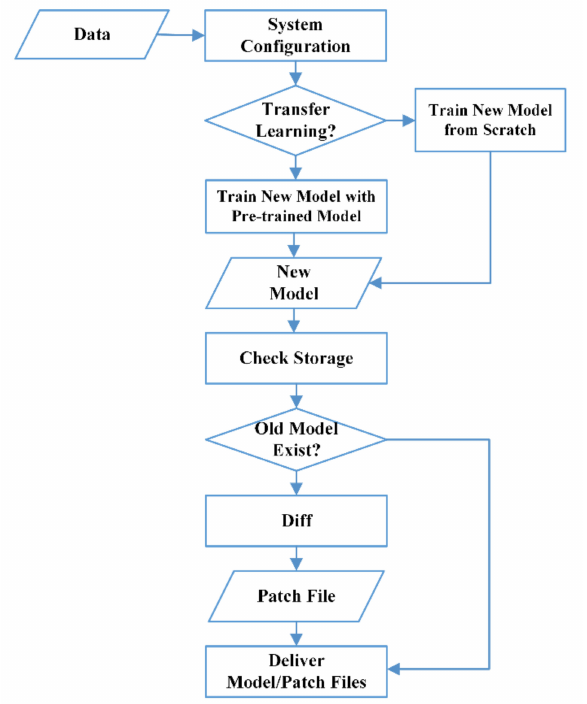
Figure 3. The workflow chart of the proposed model diff/patch